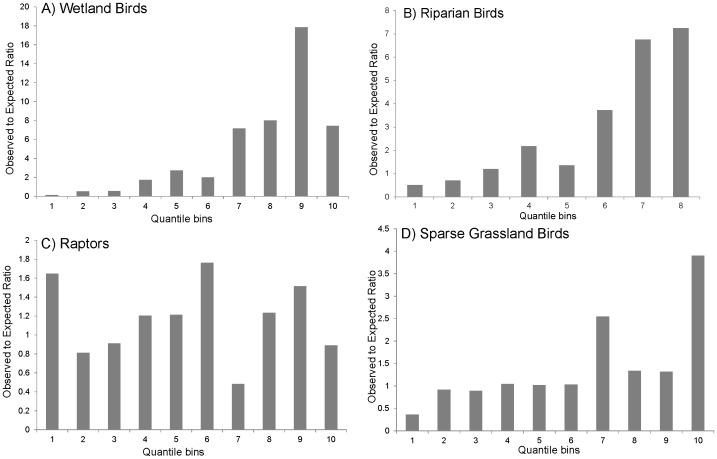
Model validation plots.The observed to expected ratio in each quantile bin used to calculate the Boyce index for validation of migration models for (A) wetland birds, (B) riparian birds, (C) raptors and (D) sparse grassland birds. Models with a perfect fit show a monotonic increase as bin numbers increase, which is best illustrated in panel A.